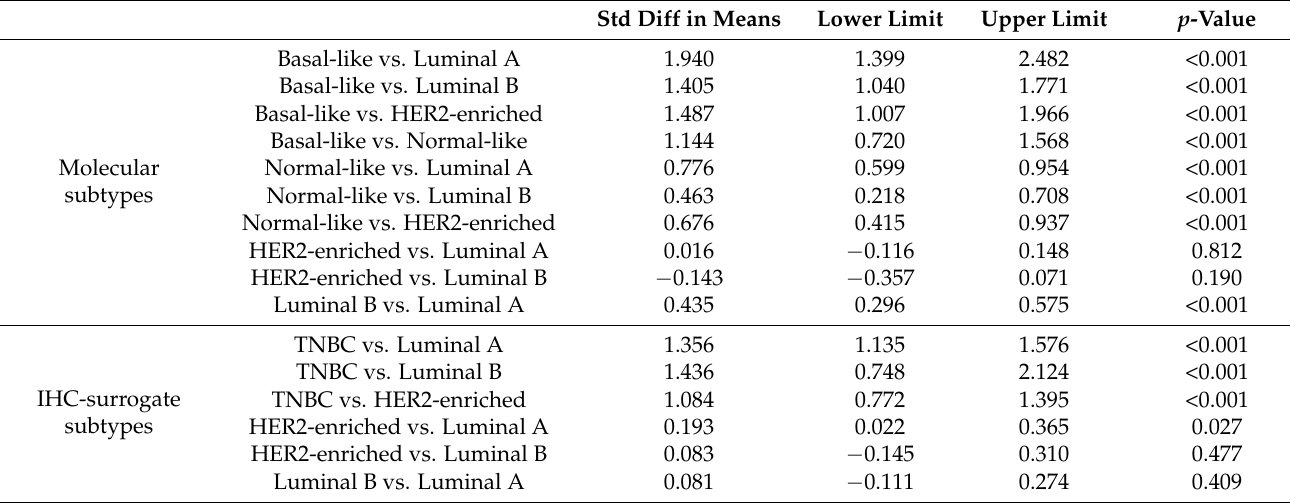
Table 2. Analysis of the association between AR mRNA expression and BC classification based on molecular subtypes and IHC-surrogate subtypes after sensitivity